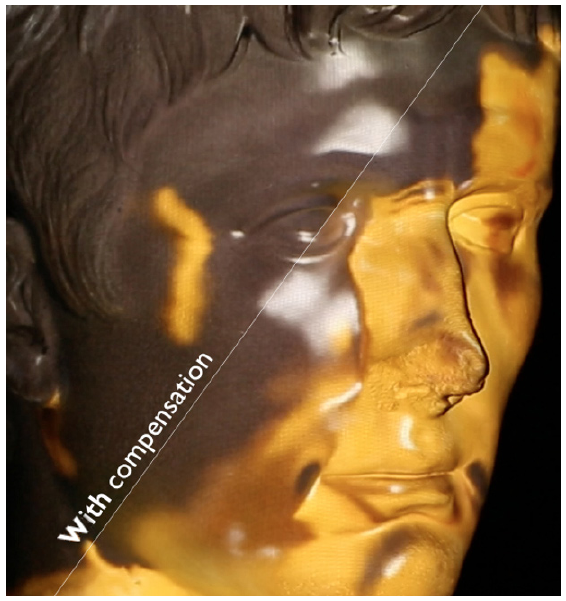
Fig. 9 Results for our interreflection correction. Notice the reduced color spill and increased contrast around the eye. disappear.